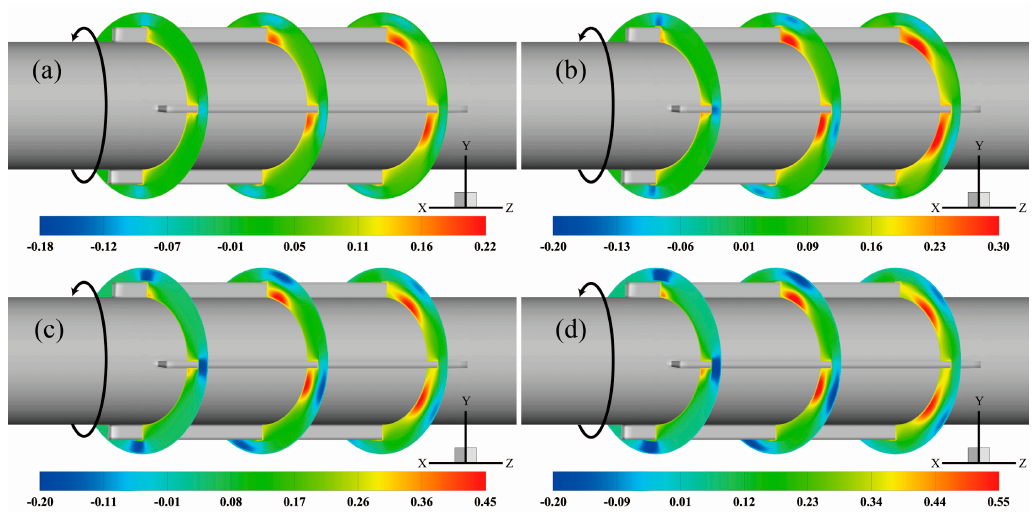
Figure 5. Tangential velocity contours with four different rotational speeds for straight blade at α = 0 ◦ : ( a ) 80 rpm; ( b ) 120 rpm; ( c ) 160 rpm; and, ( d ) 200 rpm.